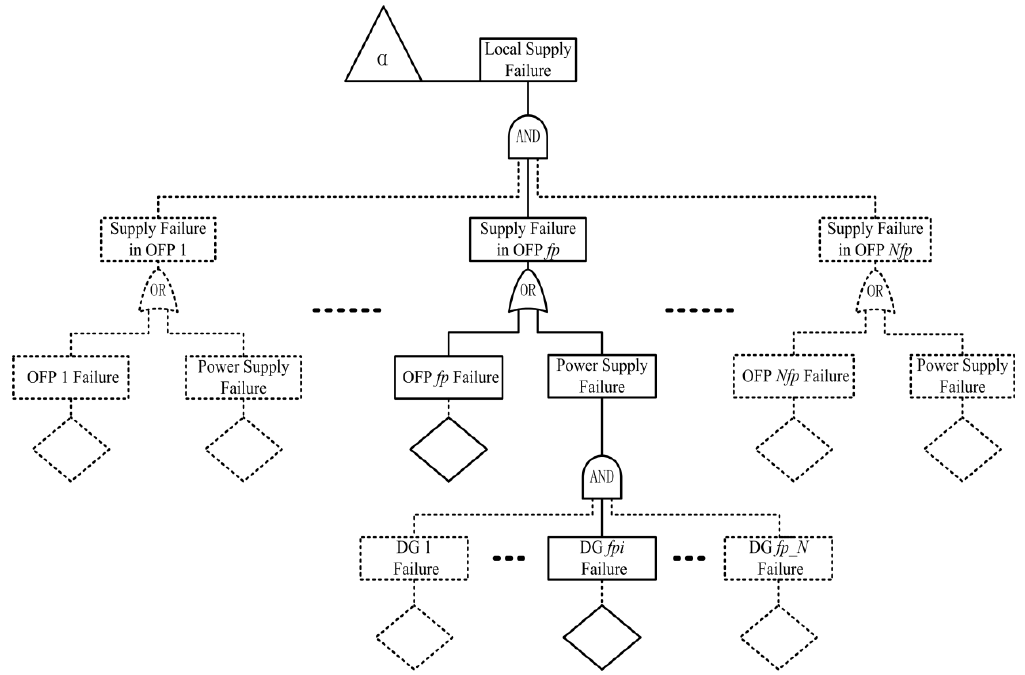
Figure 3. Normalized form of the secondary fault tree for local smart grid framework: OFP = output flow path; DG = distributed